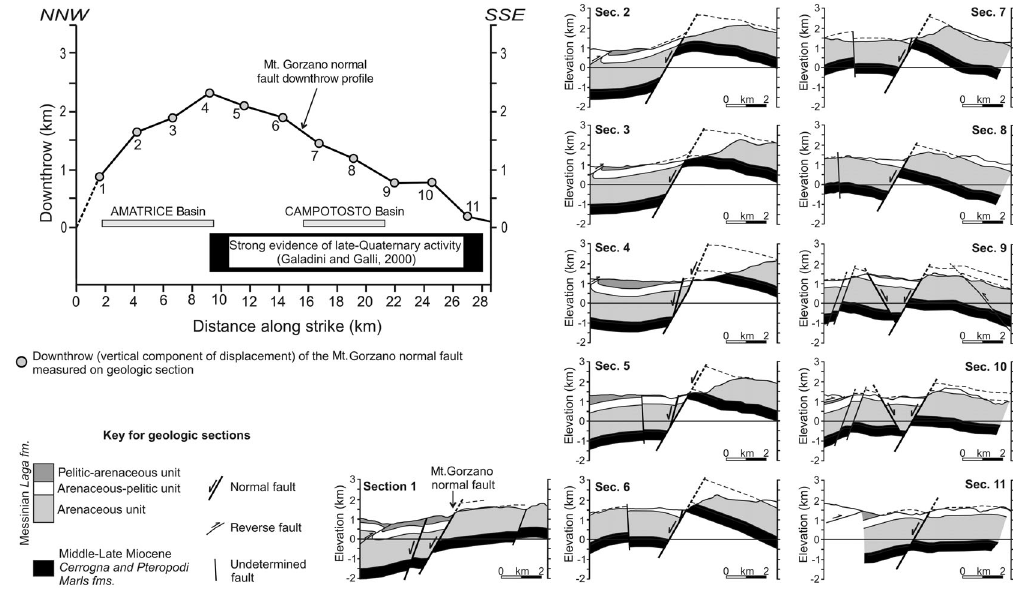
Fig. 8. Geologic sections across the Mt. Gorzano normal fault (location in fig. 7) and diagram illustrating the along-strike variation of the vertical component of net geological